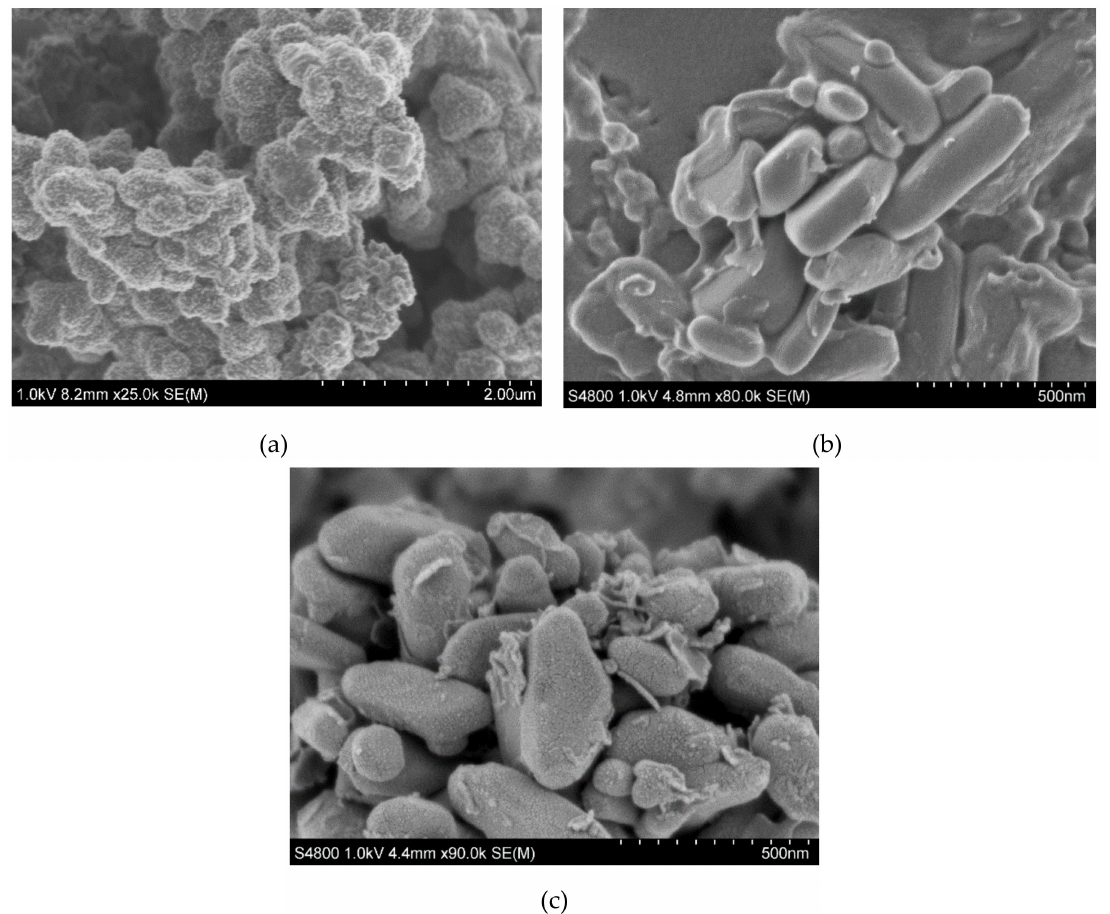
Figure 7. SEM images for ( a ) synthesized PANI, showing the agglomerates; ( b ) LiFePO 4 , showing the particles; and ( c ) LiFePO 4 –PANI hybrid.